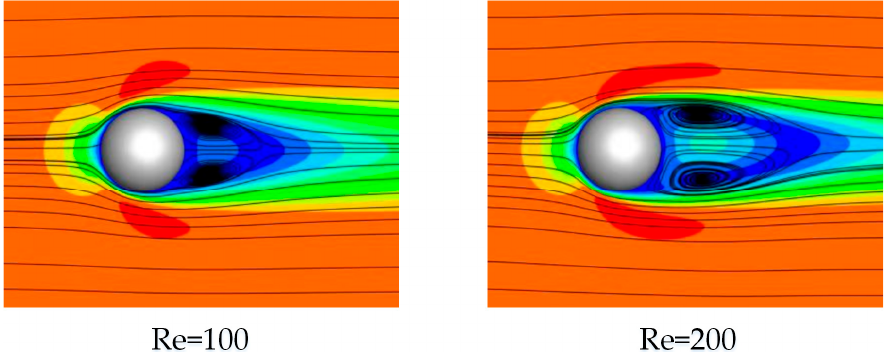
Figure 23. Streamlines and velocity contours for flow past a sphere on XY plane at different Reynolds numbers. Table 4. Comparison of drag coefficient C D at different Reynolds numbers.